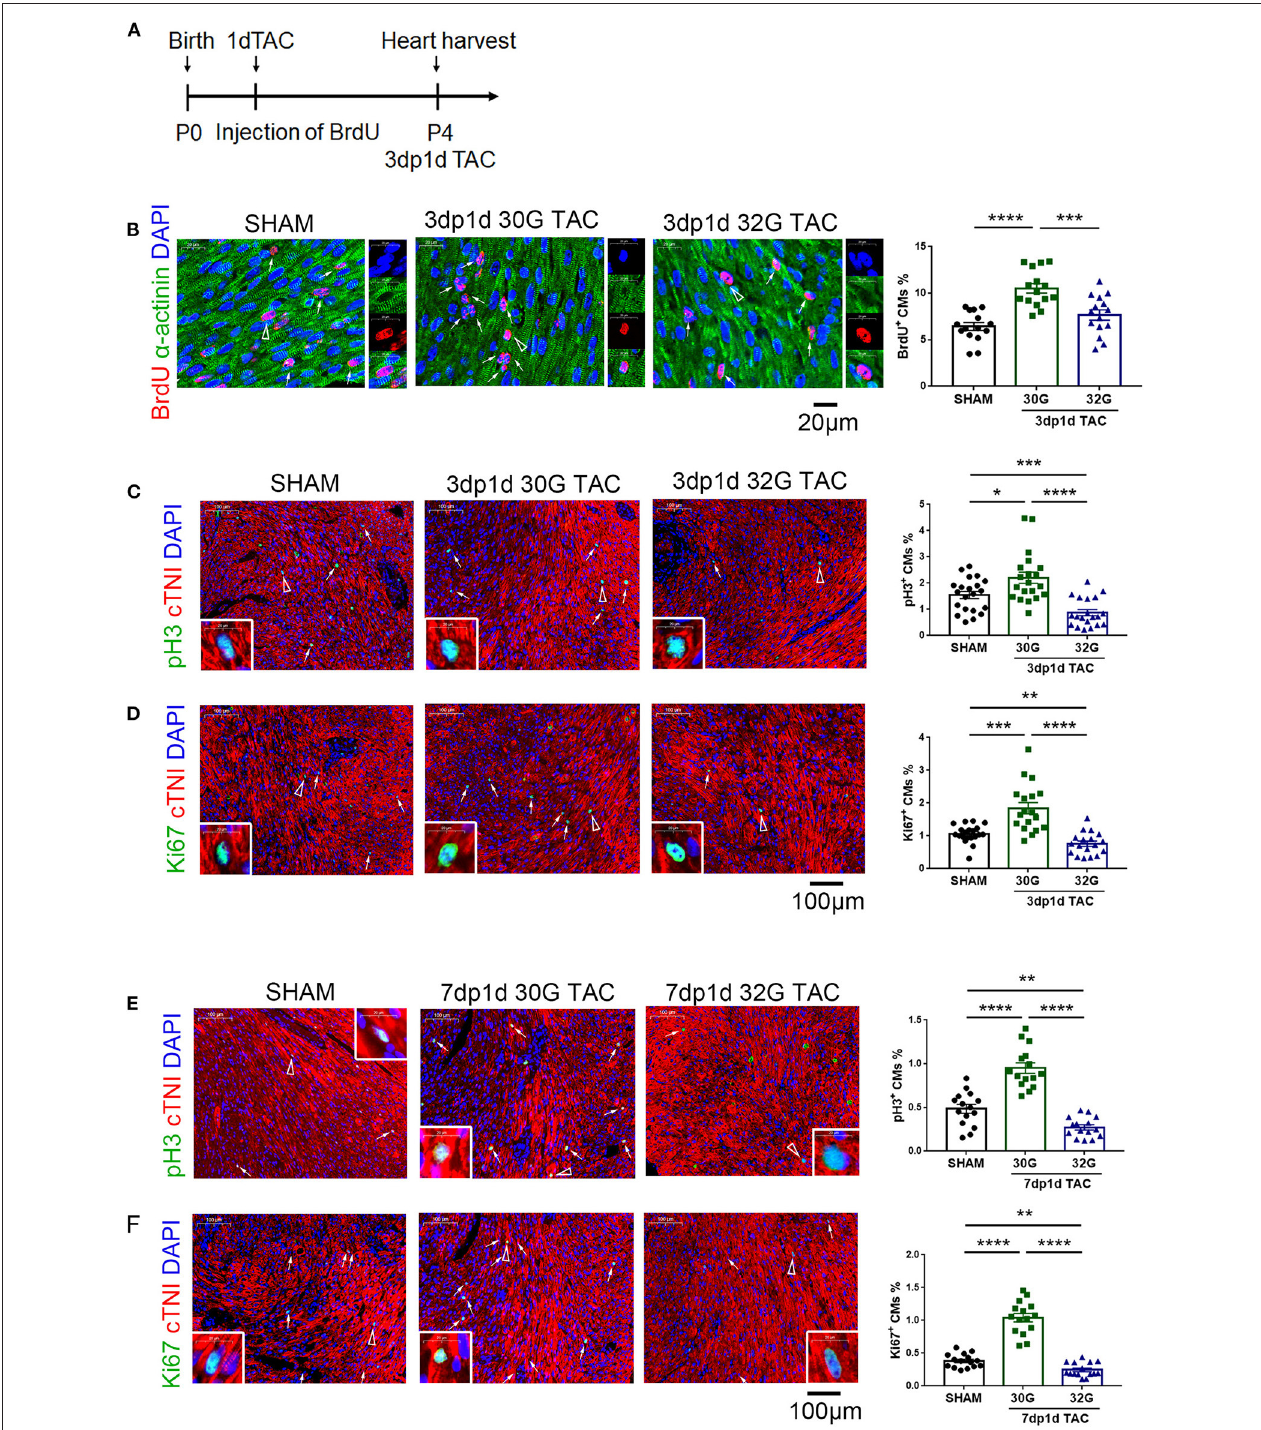
FIGURE 3 | Cardiomyocyte proliferation increased in the hearts of mice in the 30G TAC group but not in the 32G TAC group. (A) Timeline of 5-bromo-2-deoxyuridine (BrdU) injection and detection. 1dTAC: TAC performed on postnatal day 1; 3dp1d TAC: 3 days post 1 day TAC. (B) The nascent cardiomyocytes were identified by BrdU (red), 4 ′ ,6-diamidino-2-phenylindole (DAPI, blue) and α -actinin (green) co-localization in the hearts of mice in the sham, 30G TAC, and 32G TAC groups 3 days after TAC. Scale bar: 20 µ m; n = 3 hearts per group. Each heart slide was randomly selected with five high-power fields for statistical analysis. (C,D) Immunostaining for phospho-histone H3 (pH3, green) and cardiac troponin I (cTNI, red) co-localization and Ki67 (green) and cTNI (red) co-localization to recognize cardiomyocyte proliferation in the heart sections of mice in the sham, 30G TAC, and 32G TAC groups 3 days after